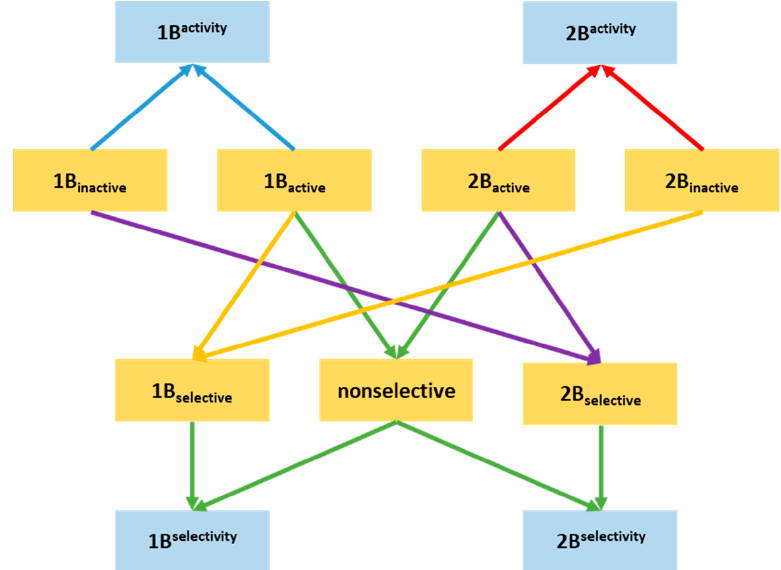
Figure 2. Depiction of Neighbouring Substructures Fingerprint (NSFP) representations of constructed compound sets (orange) and machine learning models (blue).